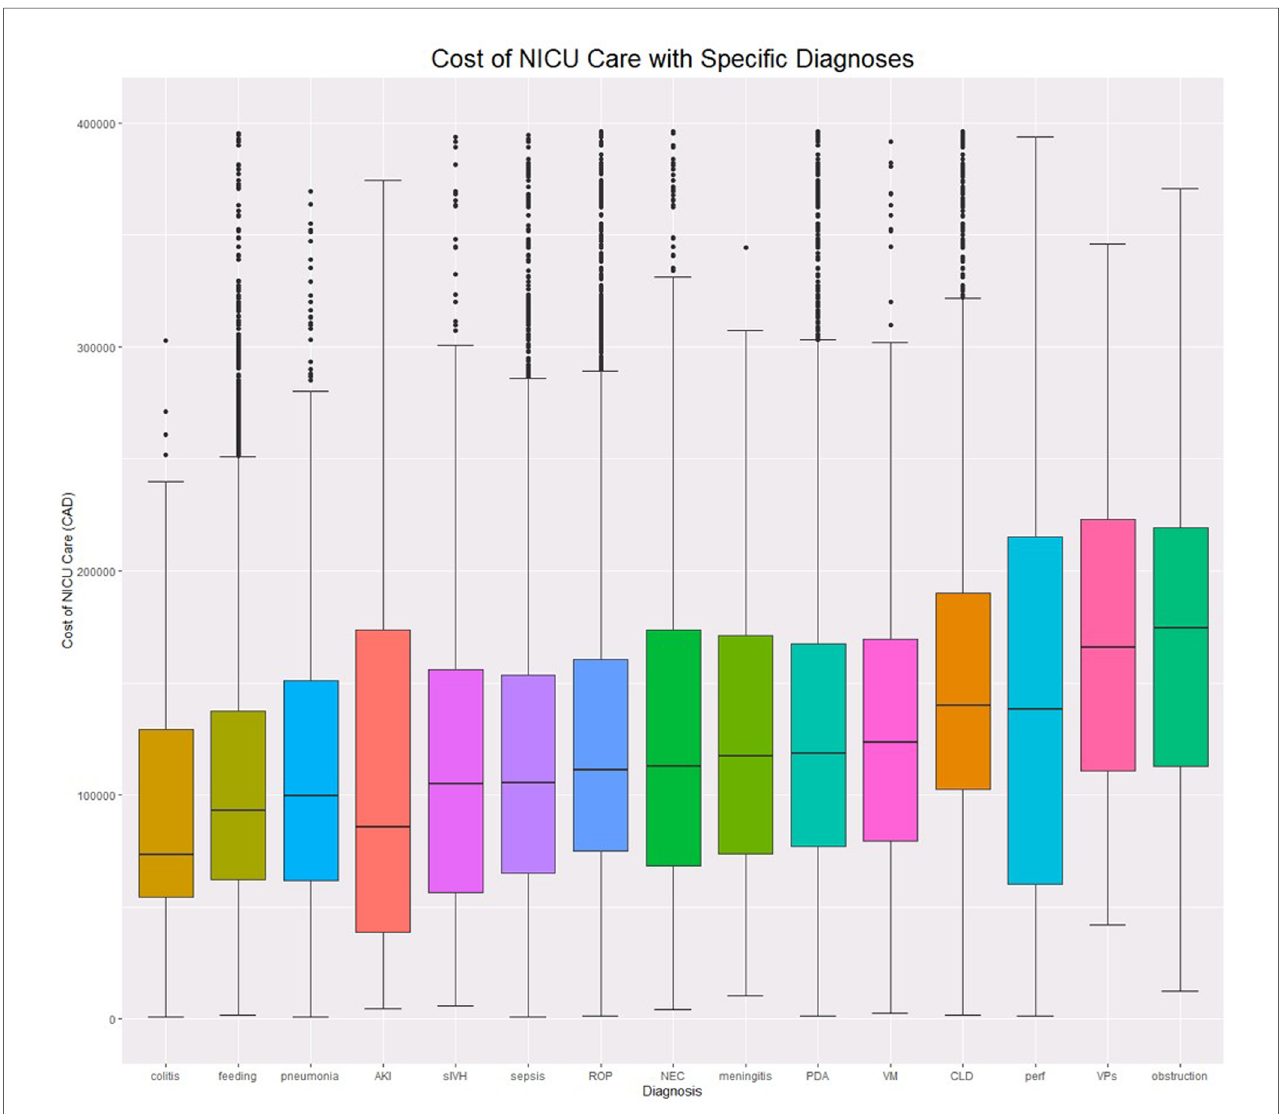
FIGURE 1 Cost boxplots by diagnosis. ROP, Retinopathy of prematurity; PDA, Patent Ductus Arteriosus; feeding, Feeding dif fi culties; NEC, Necrotizing Enterocolitis; VM, Ventriculomegaly; perf, Intestinal perforation; VPs, Ventriculoperitoneal Shunt; AKI, Acute Kidney Injury; colitis, non-NEC colitis; sIVH, Severe Intraventricular Haemorrhage; obstruction, Intestinal Obstruction; sepsis, Late Onset Sepsis; CLD, Chronic Lung